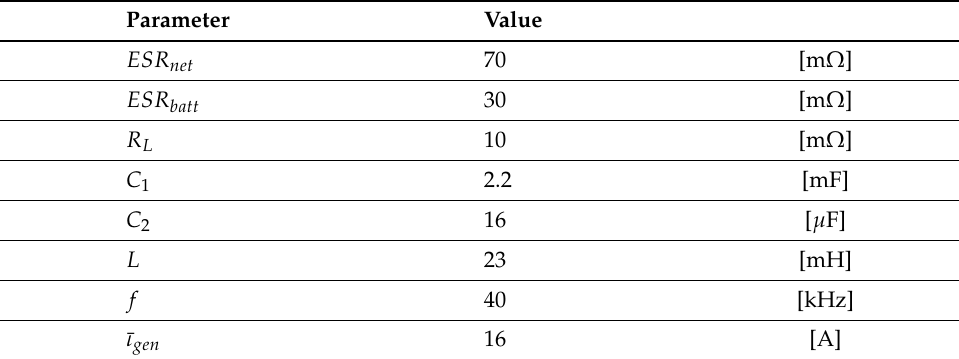
Table 1. Converter and network